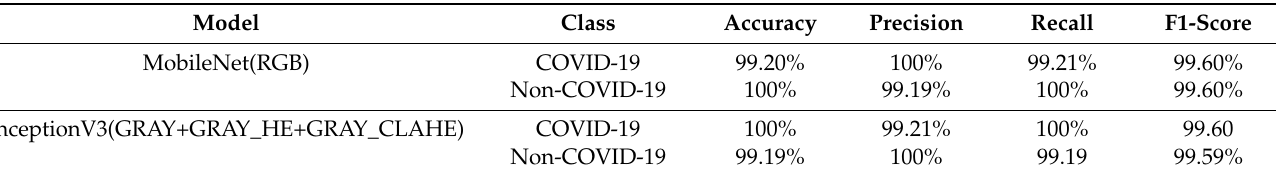
Table 8. Performance per class of the MobileNet(RGB) and InceptionV3(GRAY+GRAY_HE +GRAY_CLAHE)